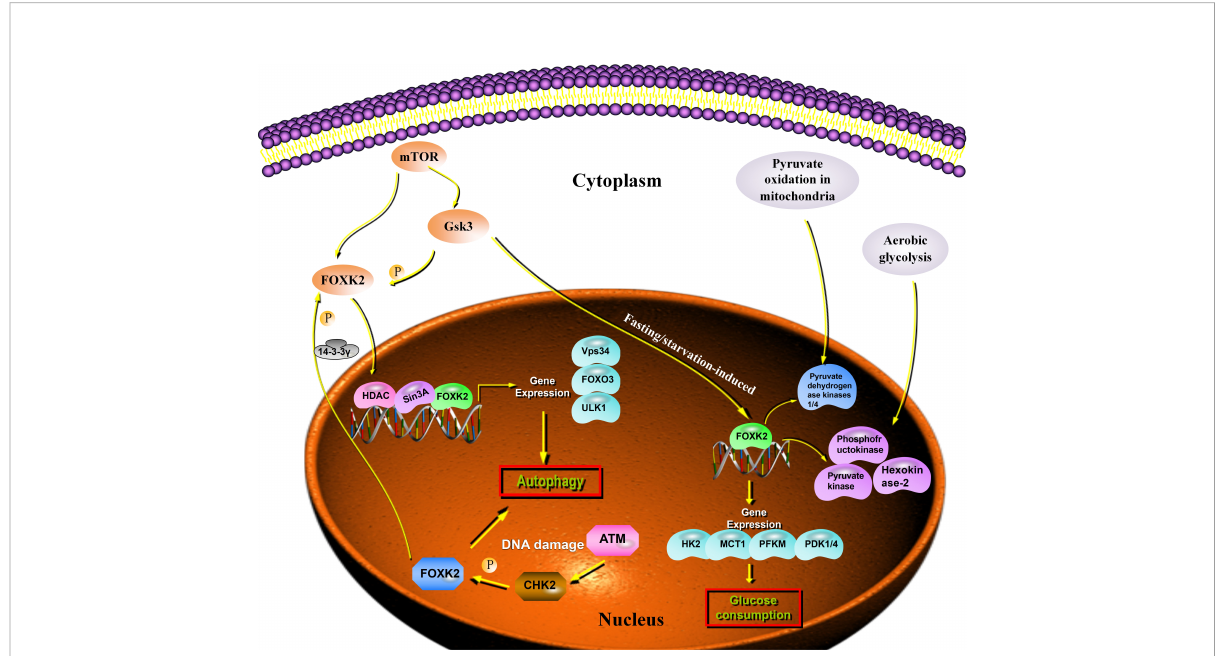
FIGURE 2 FOXK2 expression and cell metabolism. Autophagy genes are inhibited through the direct binding of FOXK2 and recruitment of Sin3A – HDAC complexes, resulting in the reduction of activating H4ac marks. FOXK2 is regulated by the downstream of mTOR. Upon DNA damage, ATM activates CHK2, which directly phosphorylates FOXK2 and creates a 14-3-3 g binding site. This site, in turn, traps FOXK2 in the cytoplasm. mTOR induces nuclear translocation of FOXK2 through GSK regulation and FOXK2 induces glucose consumption. In addition, FOXK2 regulates aerobic glycolysis and inhibits aerobic oxidation by upregulating glycolysis target